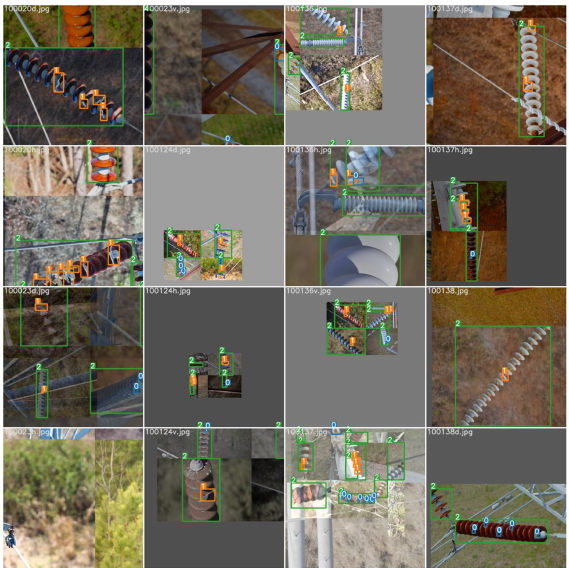
Figure 2. Renderings of data